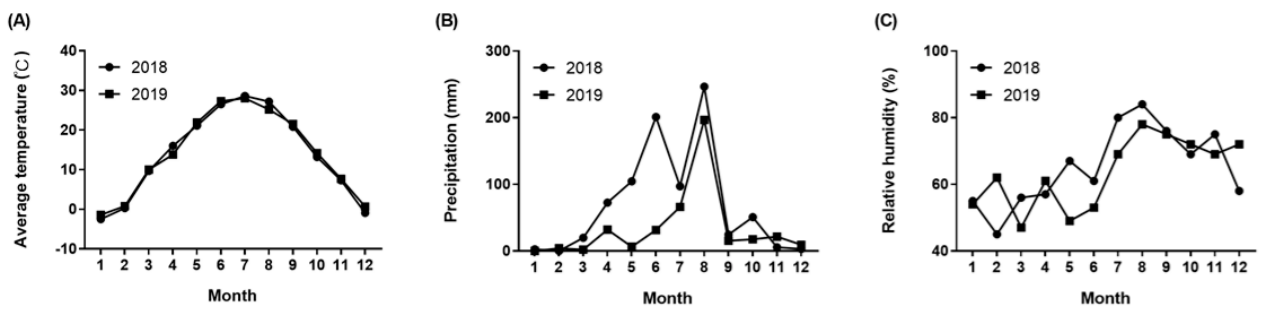
Figure 1. Meteorological data of the Jiyang area in 2018 and 2019 (Note: ( A ) average temperature; ( B ) precipitation; ( C ) relative humidity; data from the Jiyang Statistical Yearbook for 2018 and 2019, respectively; numbers 1 to 12 in the header row represent January to December).